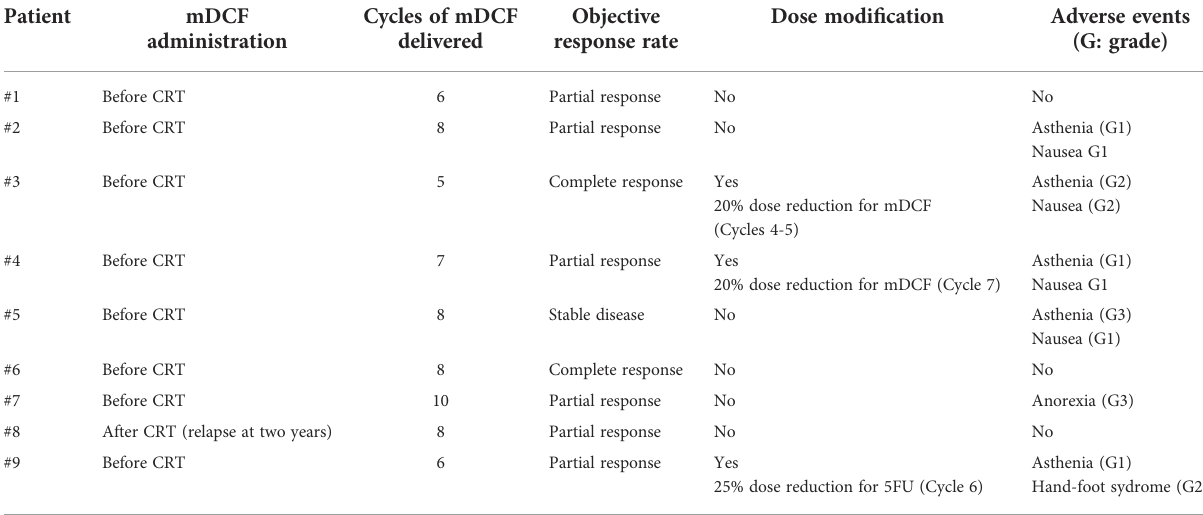
TABLE 5 mDCF administration, tumor responses and toxicities in patients with rectal squamous cell